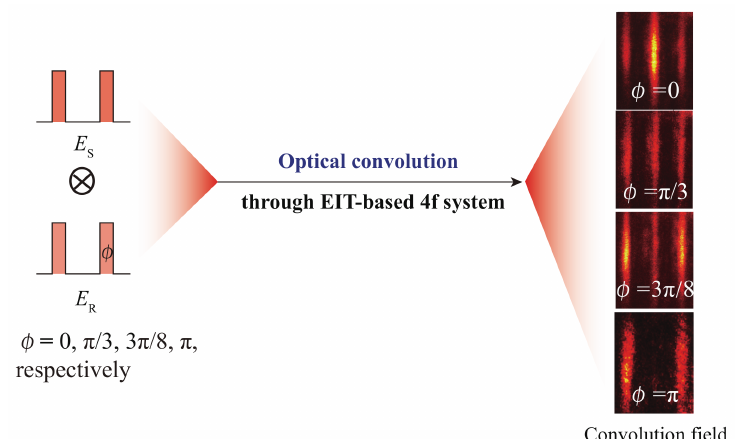
Figure 10. A schematic diagram of the direct optical convolution results of two input double-slit images with a variable phase-shift, φ , between the transmitting beams through the two slits of